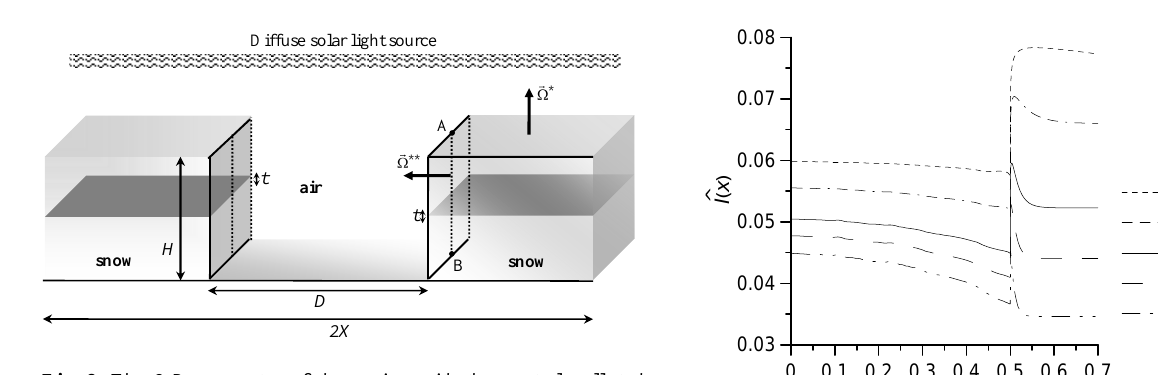
Fig. 8. The 3-D geometry of the region with the central polluted layer.